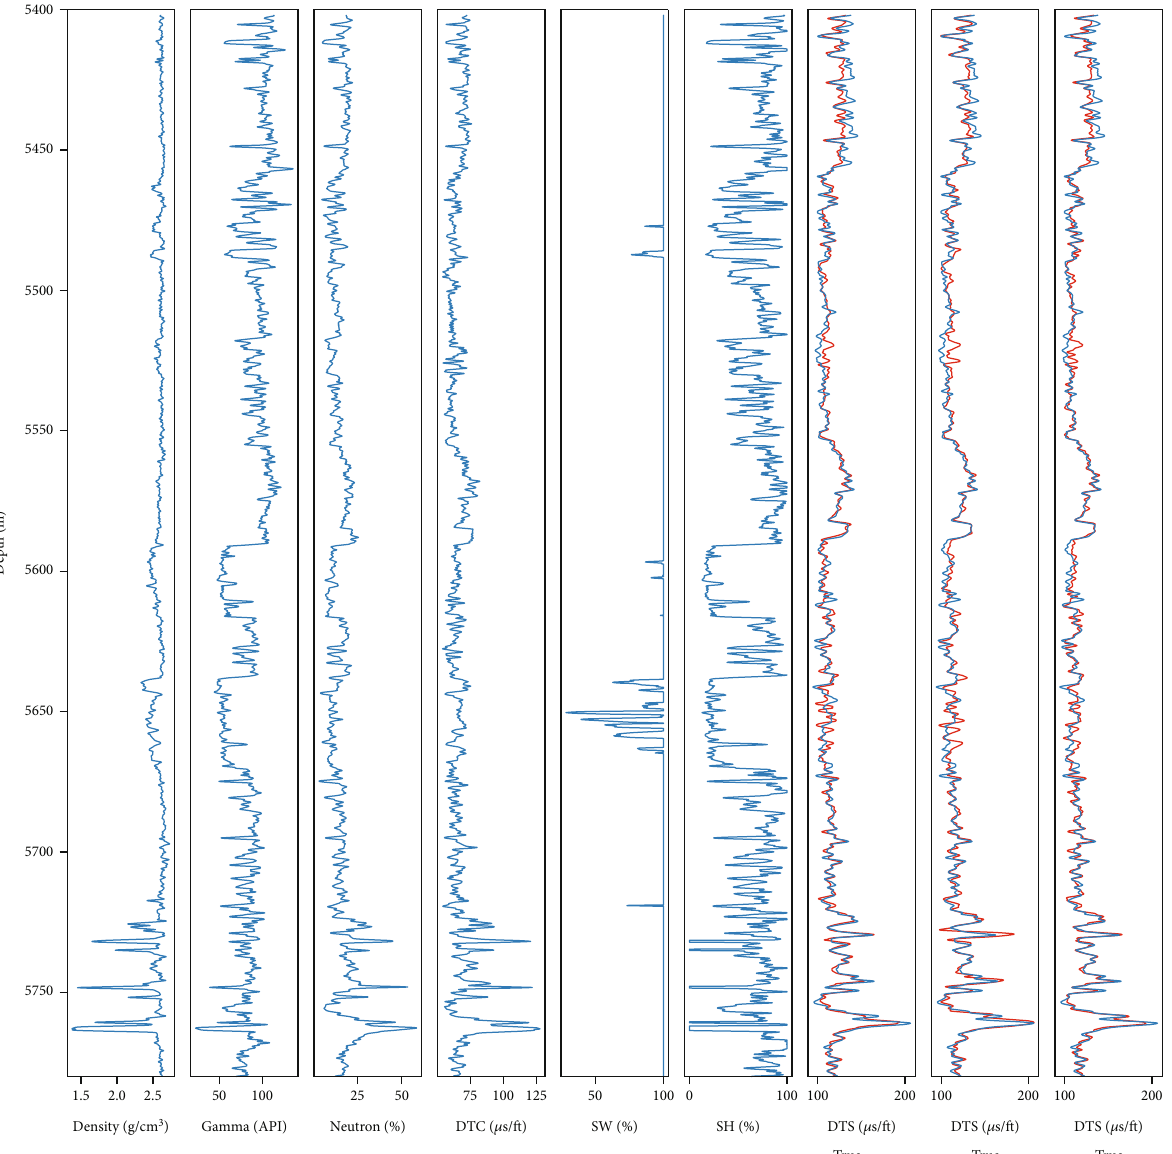
(Figure 11). The correlation coe ffi cient between the data pre- dicted by the 2DCNN-GRU hybrid network and the true values was higher than that by the other two networks and was as high as 0.866. Moreover, the MAE of 2DCNN-GRU was lower than that of 2DCNN and GRU and was as low as 0.0165. Compared with the 2DCNN-GRU hybrid net- work, the reason for the low prediction accuracy of 2DCNN and GRU is that both of them only predict shear waves from single spatial or temporal features of logging data. Therefore,